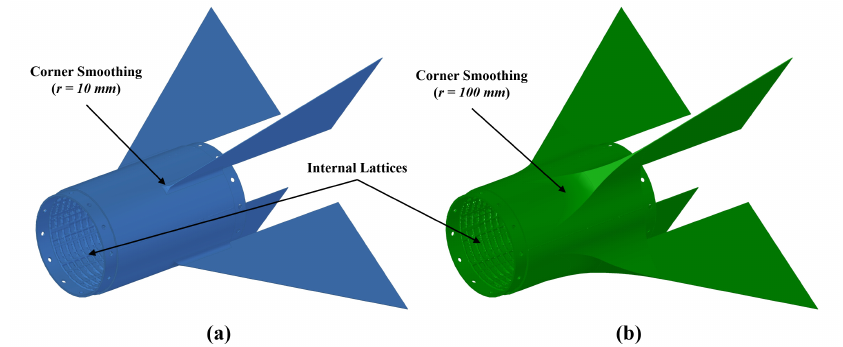
Figure 14. Redesign of payload section and upper control surfaces, where both new designs use an internal lattice and ( a ) uses a corner smoothing of r = 10 mm while ( b ) uses r = 100 mm.